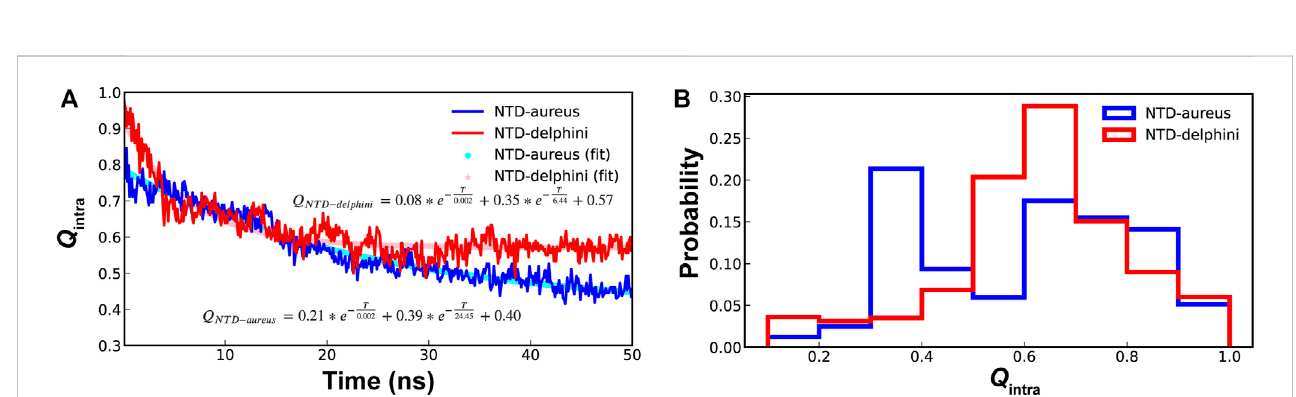
FIGURE 5 (A) Decay of NTD Q intra for SPIN-aureus (blue) and SPIN-delphini (red) at 300 K starting with the fully folded conformation, averaged over 20 replicas of 50-ns simulations. (B) Distributions of NTD Q i ntra for two SPIN